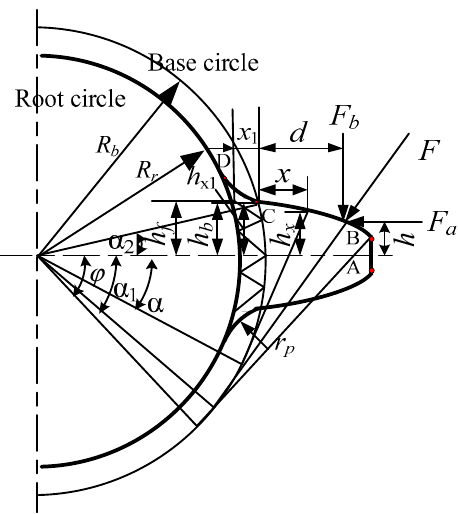
Figure 2. The force diagram of gear when the number of teeth is less than 42.